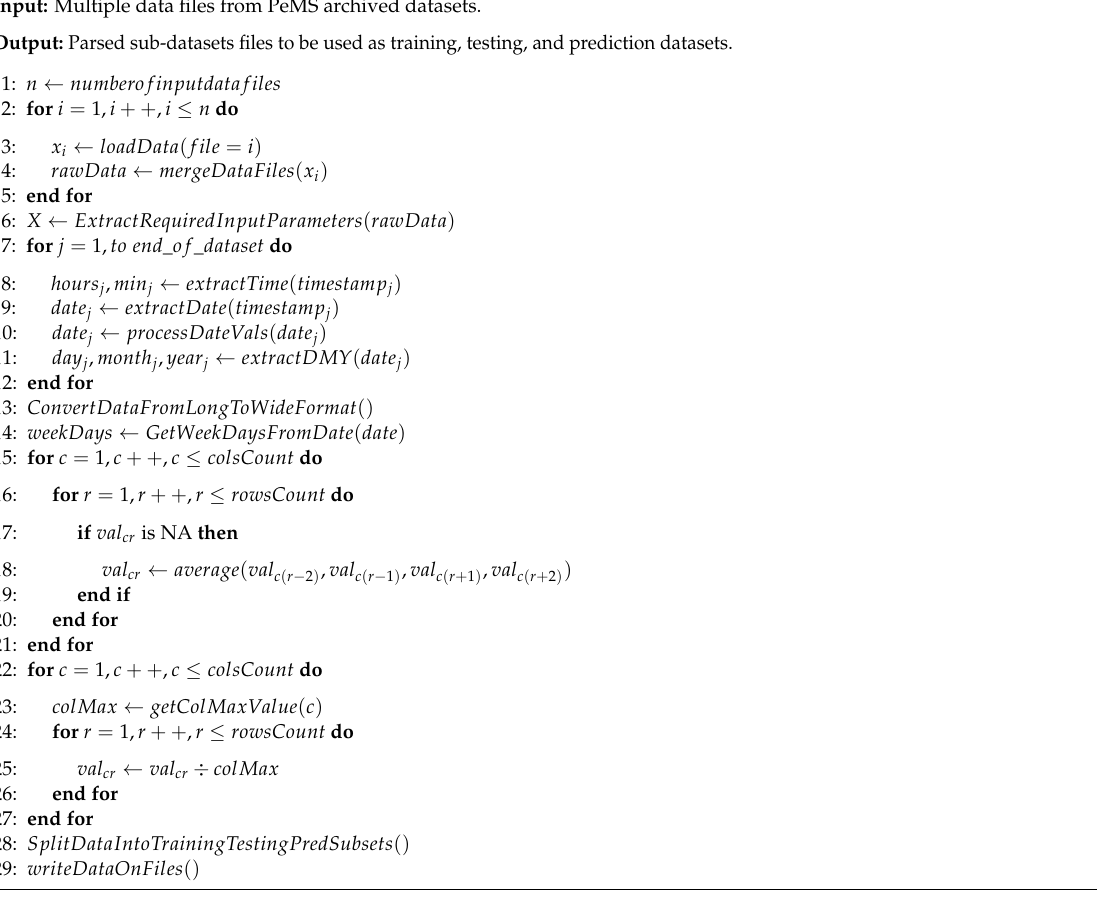
Algorithm 1 Input dataset